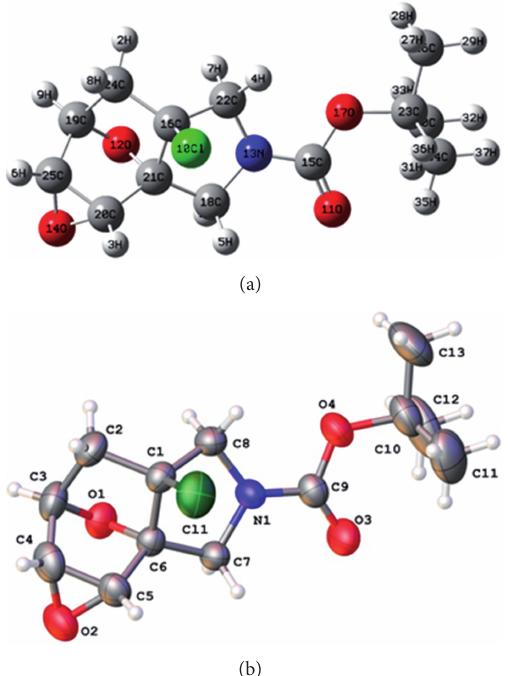
F 2: e optimized molecular structure (Conformer 2) of the title compound (a), the single crystal structure of the title compound. ermal ellipsoids are shown at the 50 level